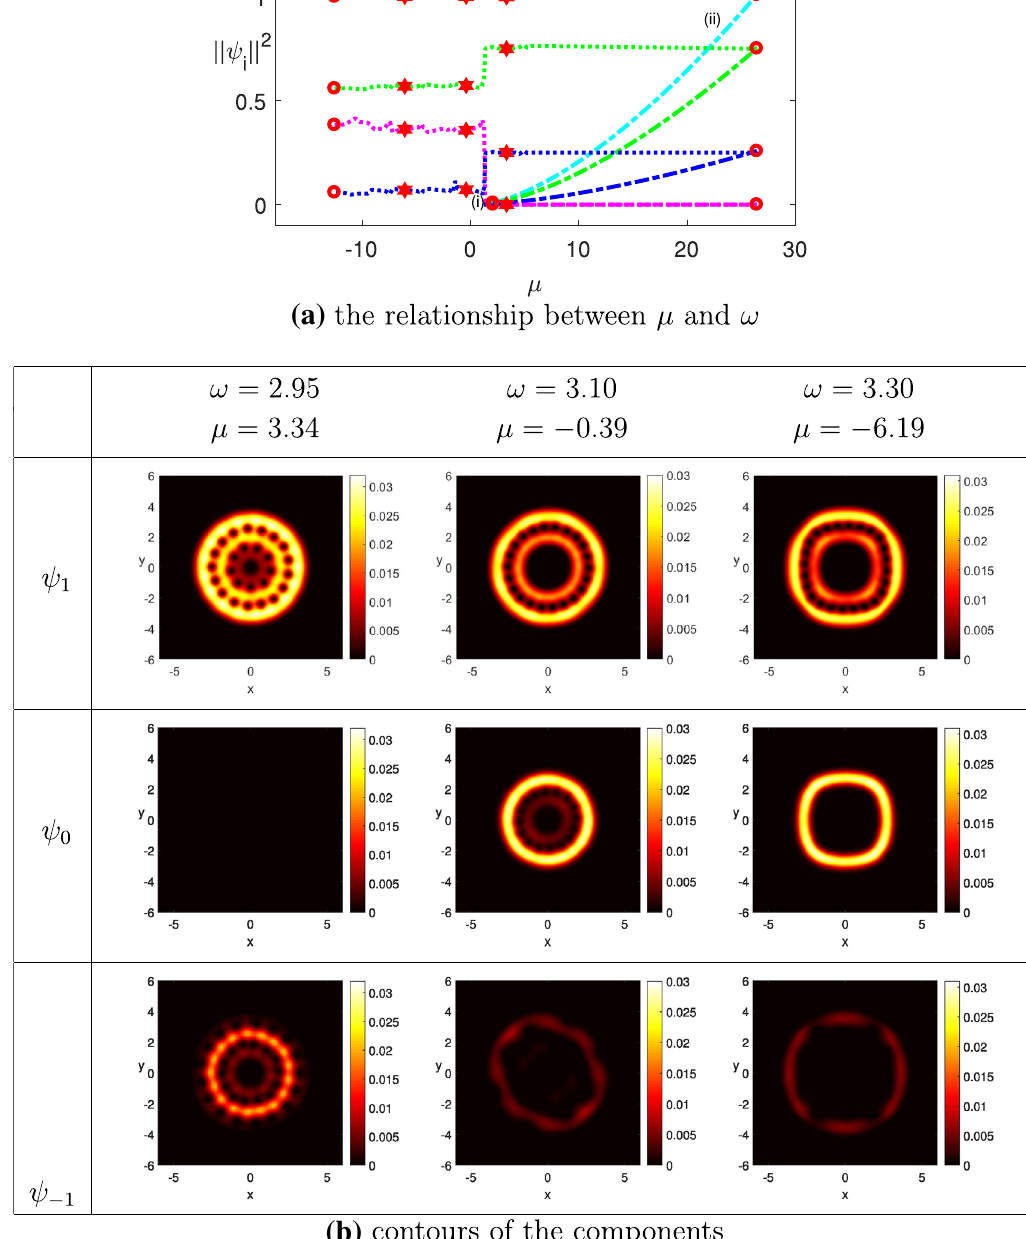
23 Na 20,000 , and ω 0.01 , M 0.5 , 3.50 N Figure 8. The ground state solution of , where k 0 ∗ = = = = (cid:31) with red color showed up in the contour of the component ψ 1 . Compared to the contours of ψ 1 and ψ 1 , the − − 3.10 , only the outer two-norm of the component ψ 0 is relatively small, namely, almost equal to zero. When ω = ring remained there with denser vortices in the domain of ψ 1 , and the location of the inner ring of vortices and the central vortex was occupied by a bigger central vortex, which was surrounded by a ring with red color. But the two-norm of ψ 1 became relatively small compared to that of ψ 1 because of the affect of the magnetization. − However, we still could observe that a central vortex was surrounded by a ring with dark red color. On the other hand, a central vortex bigger than that of the component ψ 1 was formed in the domain of the component ψ 0 ,